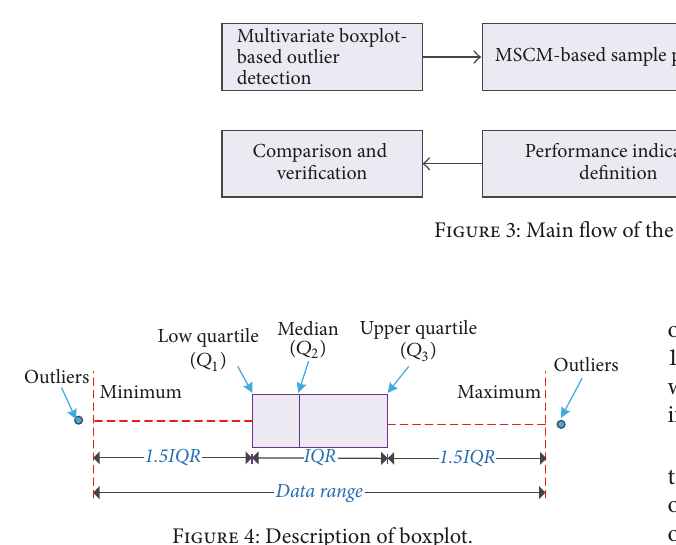
Figure 2: Number of orders for each required panel.